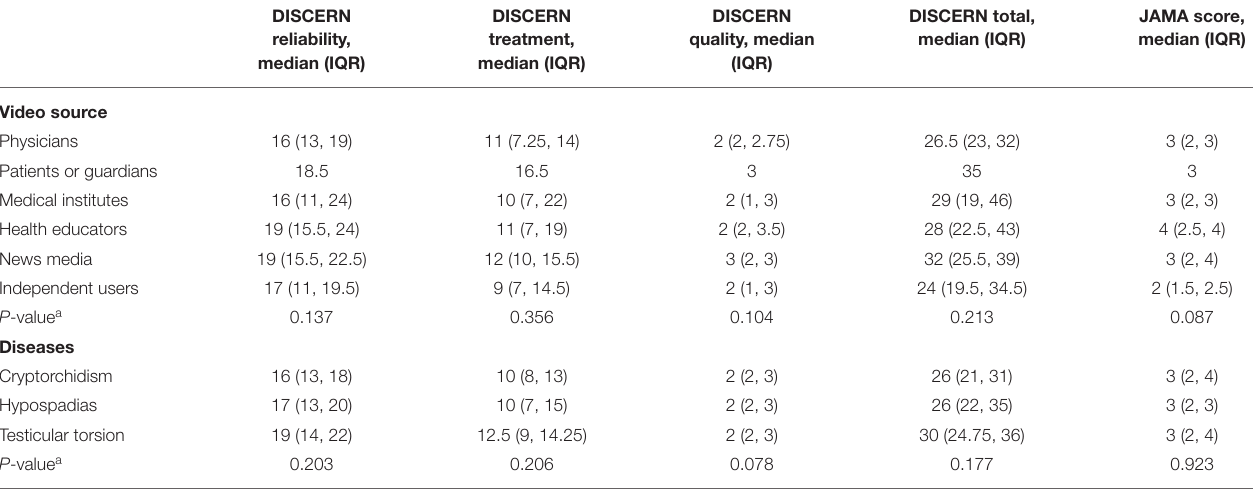
TABLE 3 | Quality assessments according to video source and diseases.